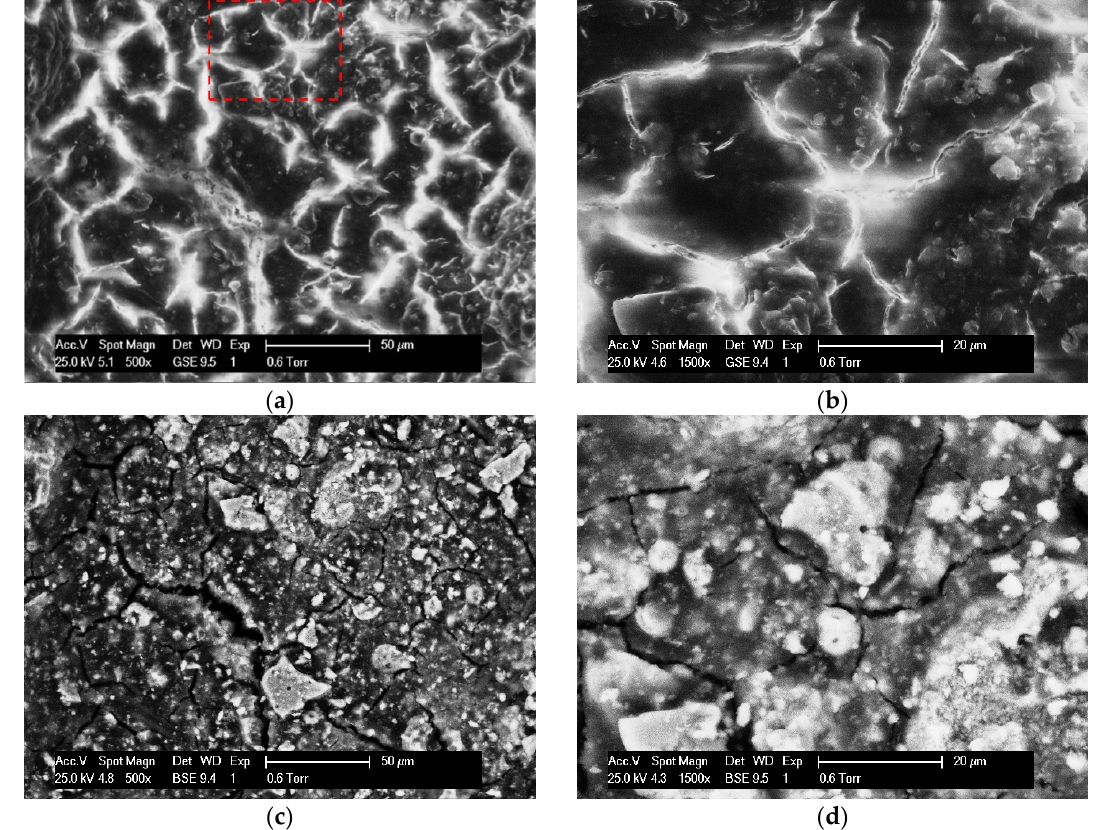
Figure 5. ESEM images: ( a ) surface of the T 10 sample; ( b ) area indicated in (a) at higher magnification; using the BSE detector, ( c ) and ( d ) were taken in exactly the same areas showed in ( a ) and ( b ), respectively.